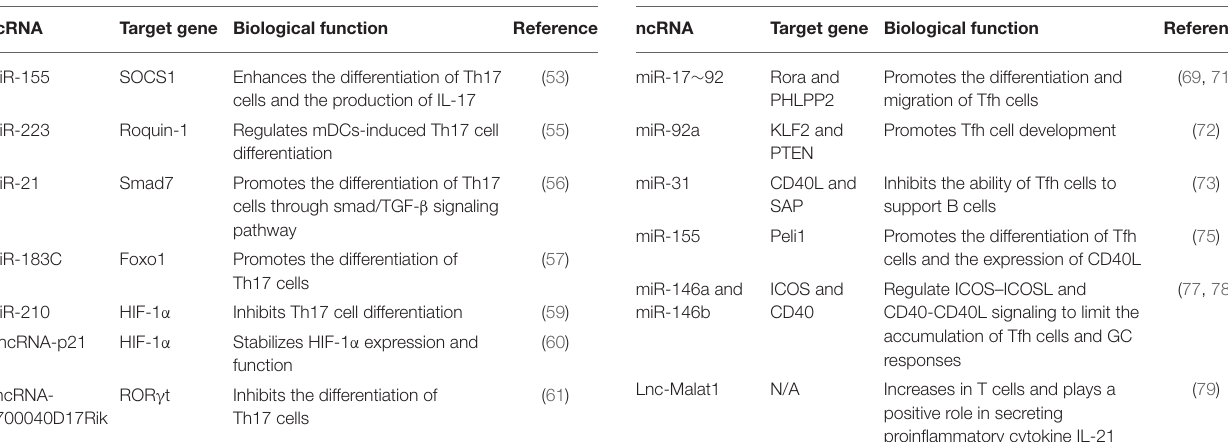
TABLE 4 | ncRNAs involved in Th17 cells. TABLE 5 | ncRNAs involved in Tfh